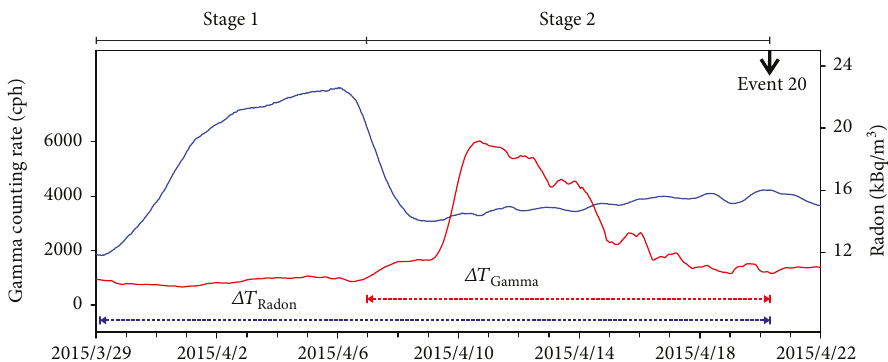
Figure 5: Variations of gamma ray and radon data during the period from March 29 to April 22, 2015. The preearthquake anomalous time from the gamma ray and radon results is represented by Δ T a gamma ray anomaly with respect to an earthquake